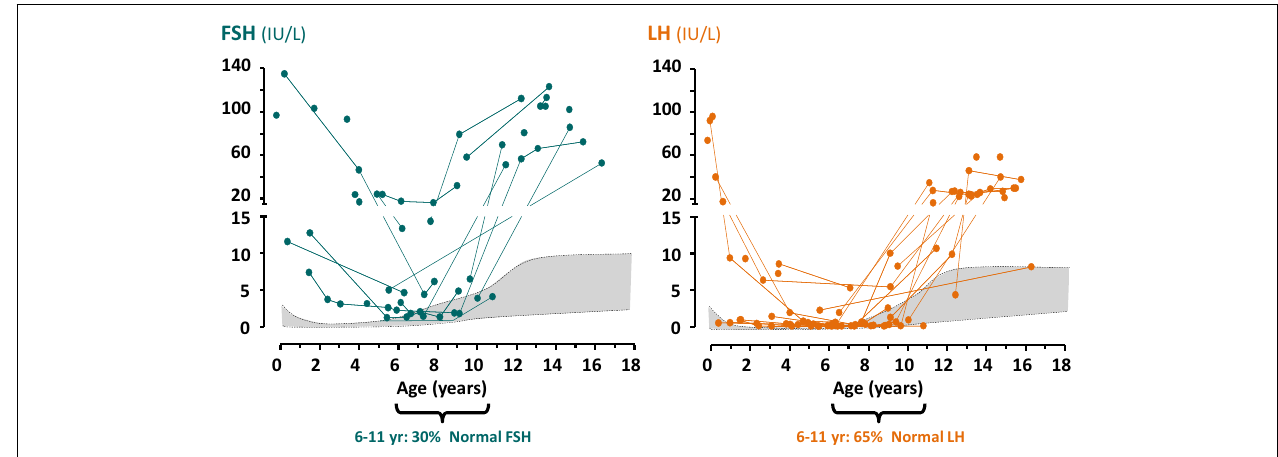
FIGURE 3 | Serum levels of gonadotropins in anorchid boys . Reproduced from Ref. (29), ©2012 Blackwell Publishing Ltd., with permission from Blackwell Publishing Ltd., JohnWiley and Sons.